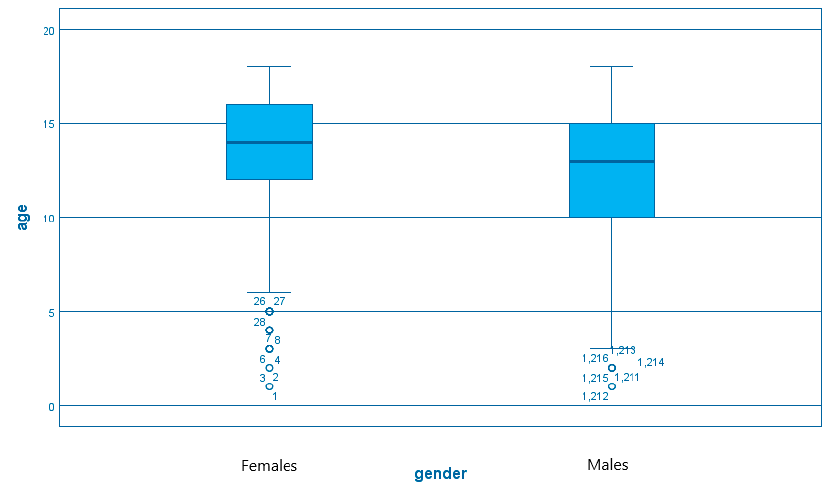
Figure 5. Distribution of H. pylori infection (number of cases) according to age (years) in males. A direct comparison between the median age of debut of the Helicobacter pylori infec- tion for males and females demonstrates similarities between both genders (Figure 6).